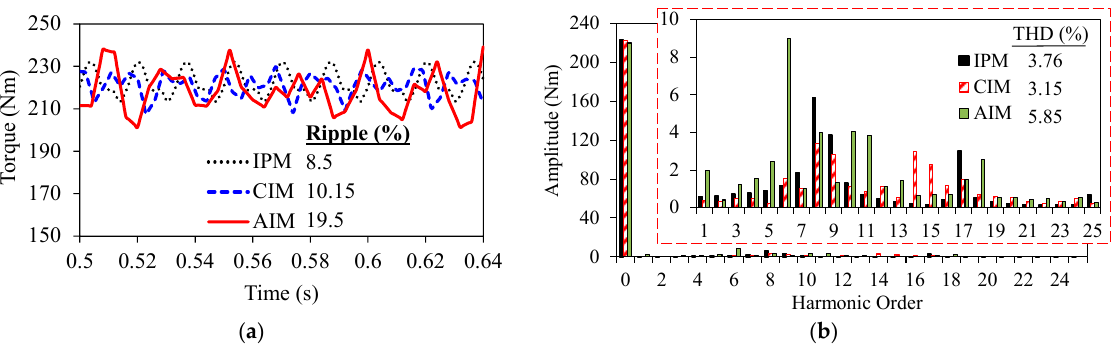
Figure 5. Comparison of the torque waveforms and their spectra. ( a ) Electromagnetic torque waveforms. ( b ) Harmonic spectra of torque.